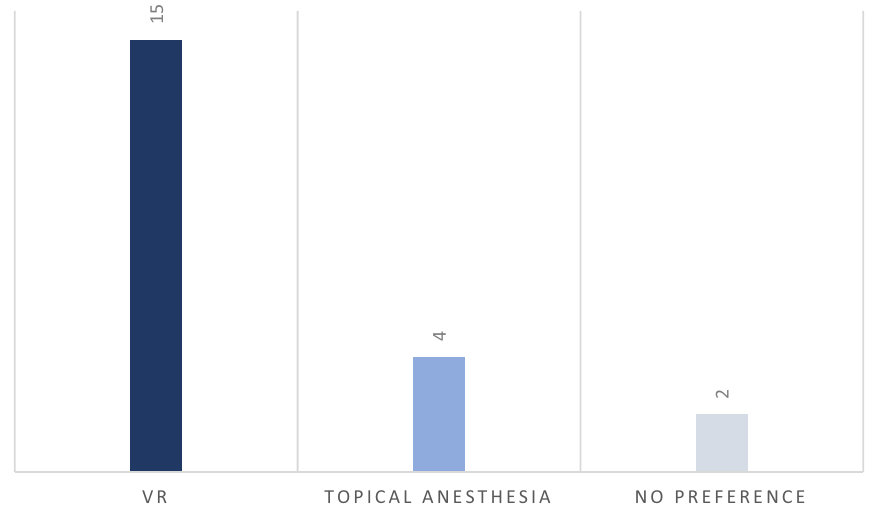
Figure 1. Stated preference of procedure by the population.